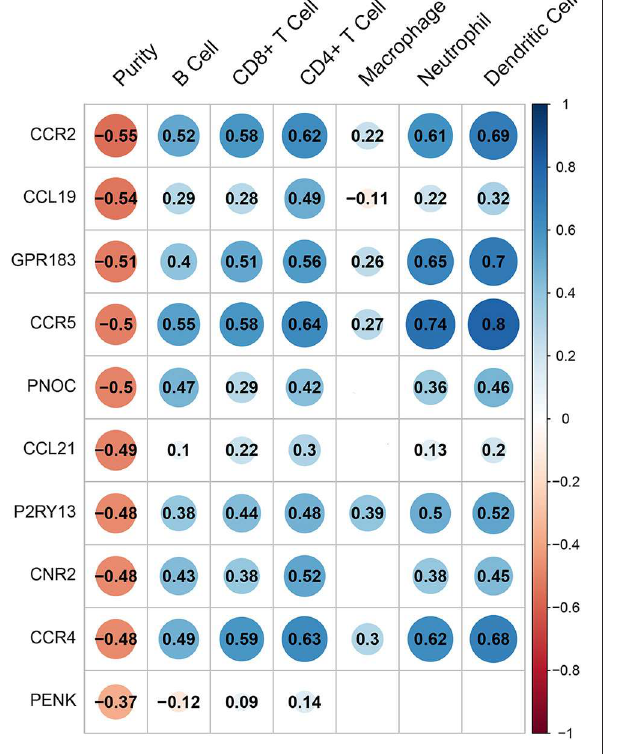
FIGURE 6 | The correlation heatmap demonstrates the relationship between gene expressions and immune cells infiltration. Dots size shows the extent of their relationships and dots color indicates if they are positive-related (blue dots) or negative-related (red dots). The number inside dots indicates the coefficients of correlation between genes expression and cells infiltration. Blank squares mean insignificance ( p >